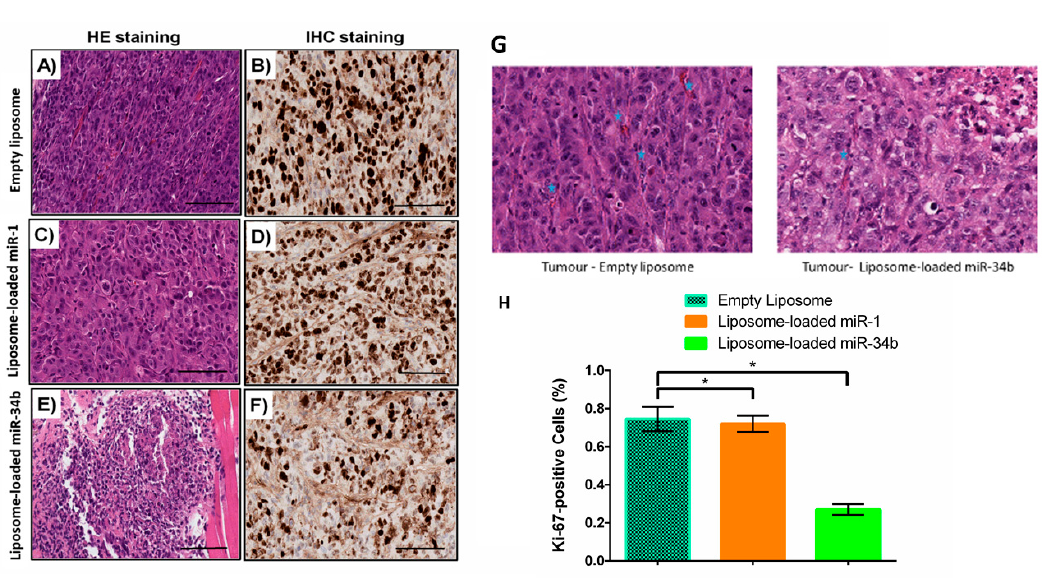
Figure 6. Liposome-loaded miR-34b decreases proliferation in xenograft nude mouse tumour. Tumour xenografts obtained by subcutaneous injection of anaplastic thyroid carcinoma (BHT-101) were formalin fixed and paraffin embedded. 3 µ m-thick sections were cut for histological and Ki-67 immunohistochemistry analysis. Photographs of the hematoxylin and eosin-stained tissue sections of anaplastic thyroid carcinoma on day 56 after seven intravenous injections of liposome-loaded miR-34b, liposome-loaded miR-1 and empty liposome. 40 µ g miRNA was used per dose ( A , C , E ). The carcinoma in the liposome-loaded miR-34b ( E ) was less cellular, less mitotic active and with lower nuclear pleomorphism than other 2 groups ( A , C ). The empty liposome treated tumour tissue shows frequent mitosis and more vessels (marked by stars) when compared to the liposome loaded-miR-34b treated tumour ( G ). The treated tumour shows prominent necrosis. Analysis of cell proliferation by Ki-67 immunostaining in tissue sections of thyroid carcinoma. Representative images of Ki-67 immunostaining (40 × ) ( B , D , F ), and percentage of Ki-67-positive cells ( H ) in thyroid carcinoma. Higher Ki-67 proliferative index were formed in mice receiving liposome-loaded miR-1 and empty liposome ( B , D ) whereas lower proliferative index was generated in mice treated with liposome-loaded miR-34b ( F ). Results are expressed as mean ± SD. Level of significance, * p < 0.05, when compared to the control groups. Bar represents 250 µ m ( A – F